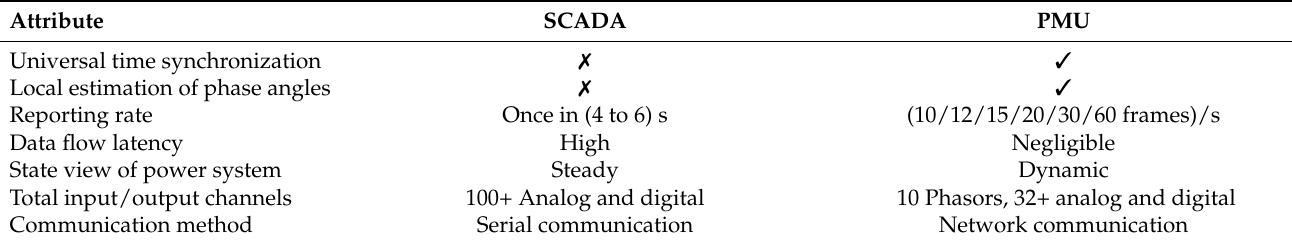
Table 1. Different attributes of SCADA and PMU in